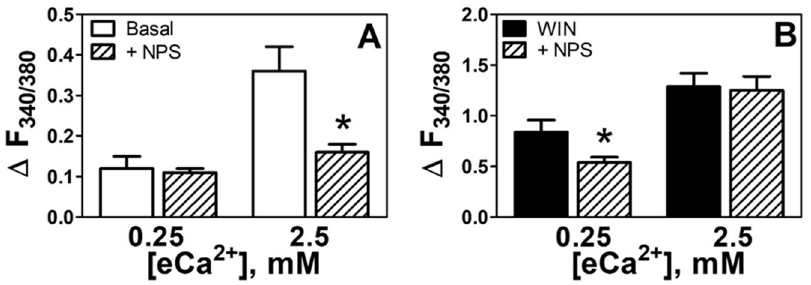
Figure 2. Increases in [Ca 2+ ] i depend on the CaSR. ( A ). Effects of the CaSR inhibitor NPS2314 3 μ M (+NPS, diagonal stripes upward bars, n = 7) on [Ca 2+ ] i in basal conditions (open bars, n = 6). ( B ). Effects of the CaSR inhibitor NPS2314 3 μ M (+NPS, diagonal stripes upward bars, n = 7) on [Ca 2+ ] i in the presence of WIN55212-2 5 μ M (black bars, n = 7). * p < 0.05 vs. basal or WIN55212-2 at the corresponding eCa 2+ .